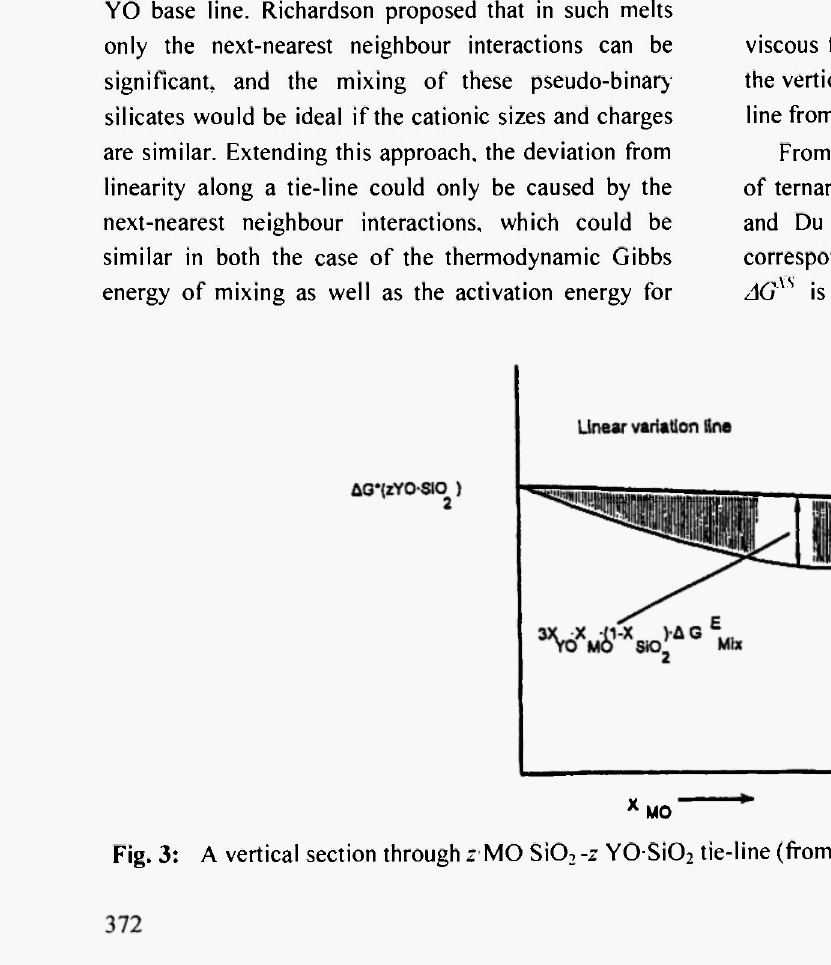
Fig. 2: The triangular representation of the system M0-Y0-Si0 2 . The variation of the viscosities of the two silicate systems MOSiC) 2 and Y0 Si0 2 are also presented in this figure.